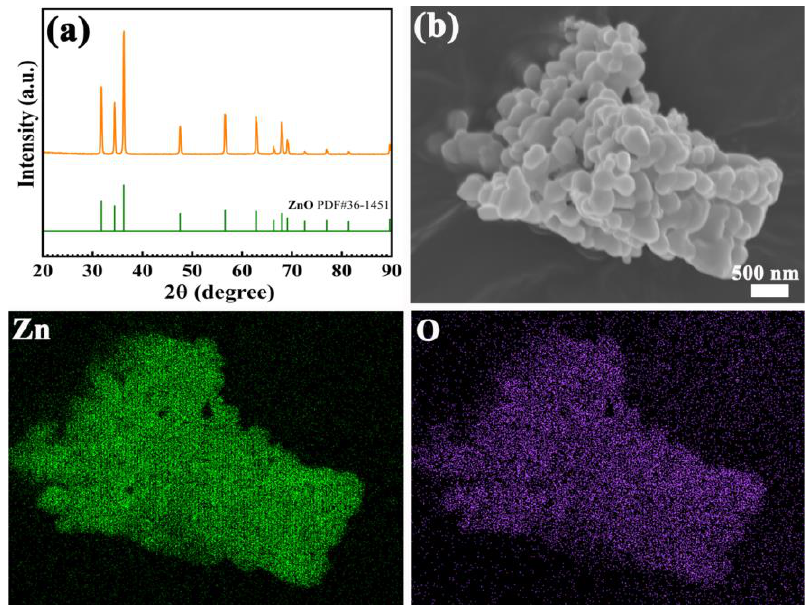
Figure 2. XRD patterns ( a ); SEM ( b ) and element mapping images of ZnO nanoparticles.